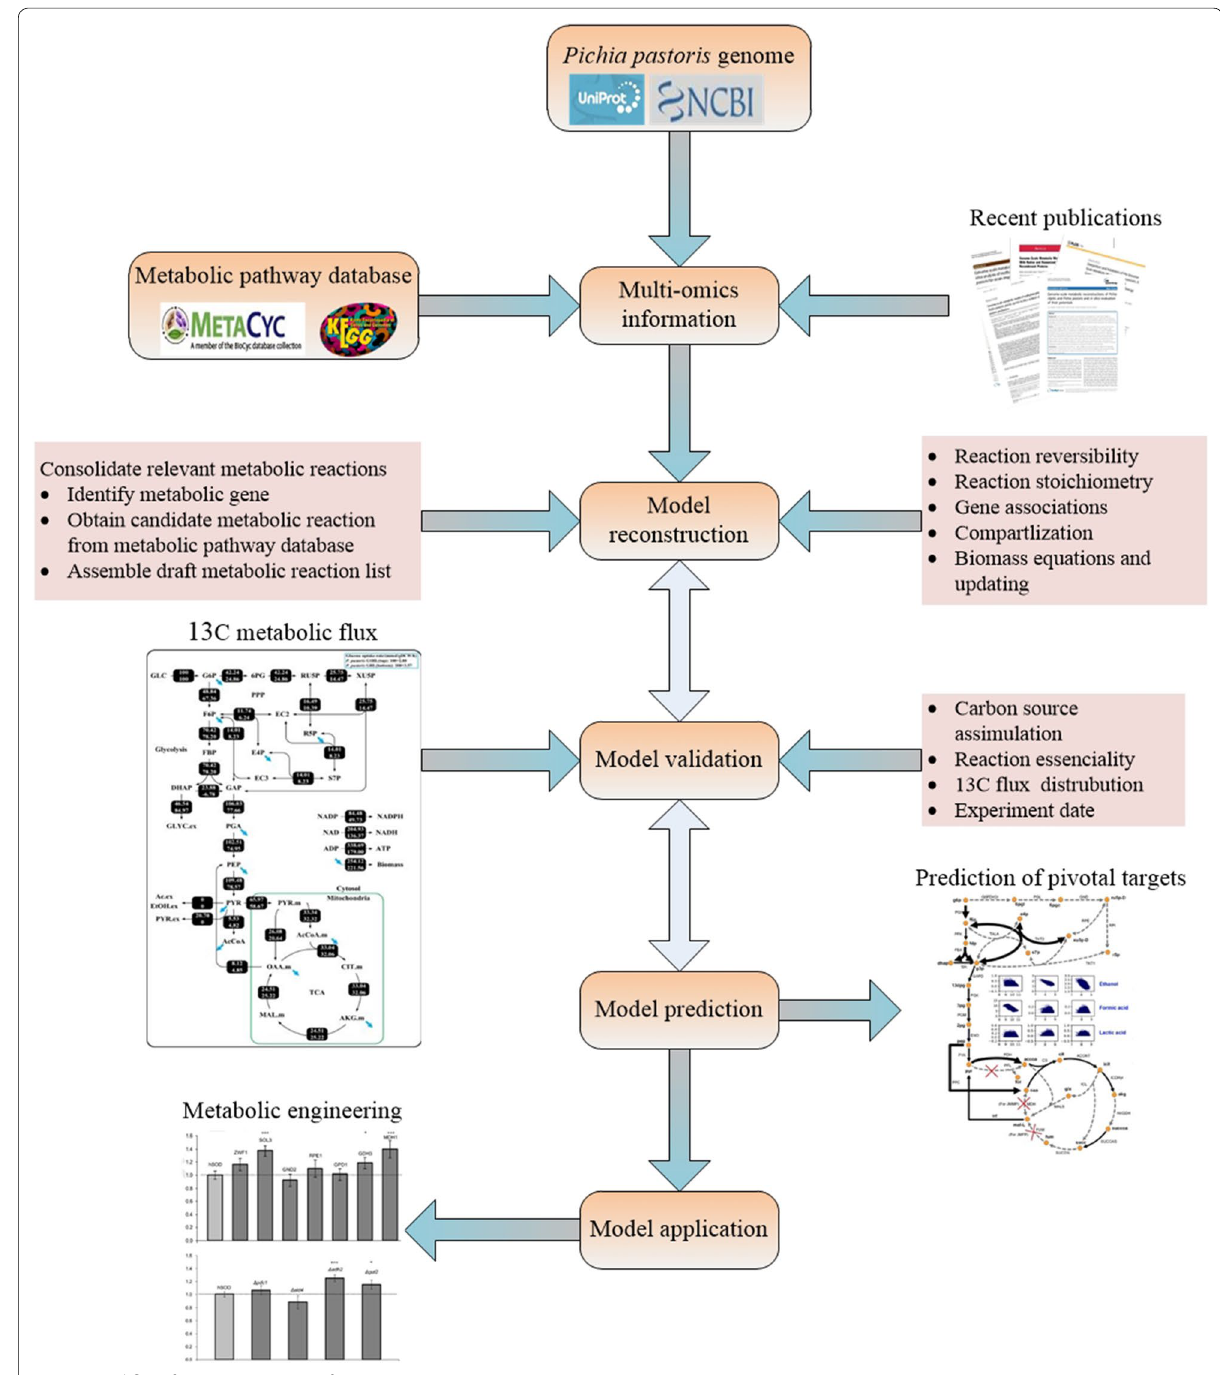
Fig. 1 Workflow for reconstruction of P. pastoris GSMM